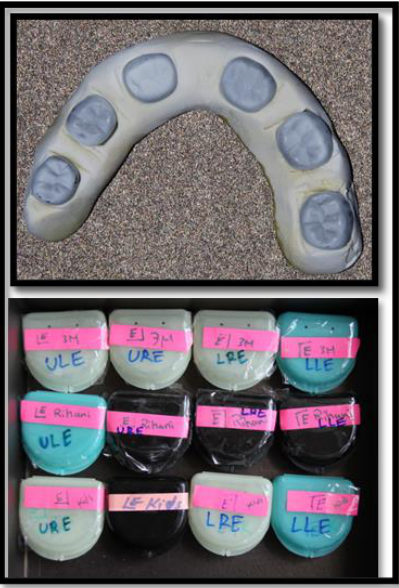
Figure 1: mounting and labeling one of each size of stainless steel crown on silicon impression material.